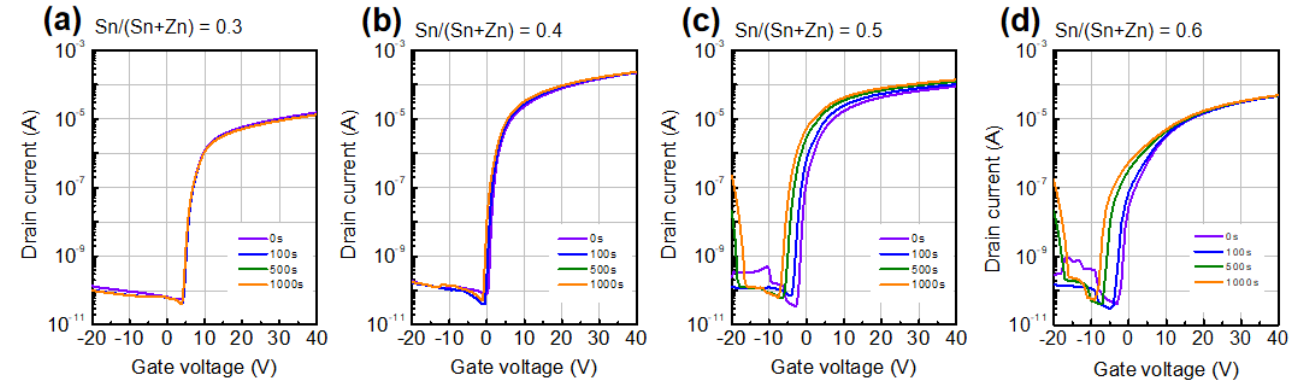
Figure 6. Transfer characteristics of ZTO TFTs with Sn/(Sn+Zn) ratios of ( a ) 0.3, ( b ) 0.4, ( c ) 0.5, and ( d ) 0.6 under NBS for stress time.